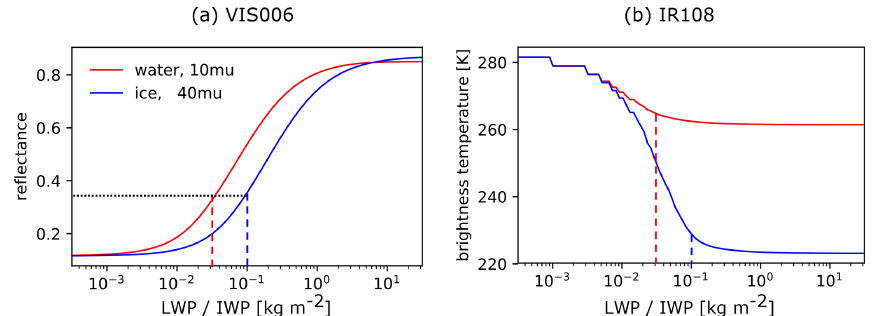
Figure 2. Water and ice cloud signals with different effective particle radii from 0.6µm SEVIRI solar reflectance (VIS006) (a) and 10.8µm SEVIRI brightness temperature (IR108) (b) , computed using DISORT. Dashed lines indicate saturation in IR108 for water (red) and ice (blue) clouds. The albedo was set to 0.1, the solar zenith angle was set to 30 ◦ , the satellite zenith angle was set to 60 ◦ and the scattering angle was set to 135 ◦